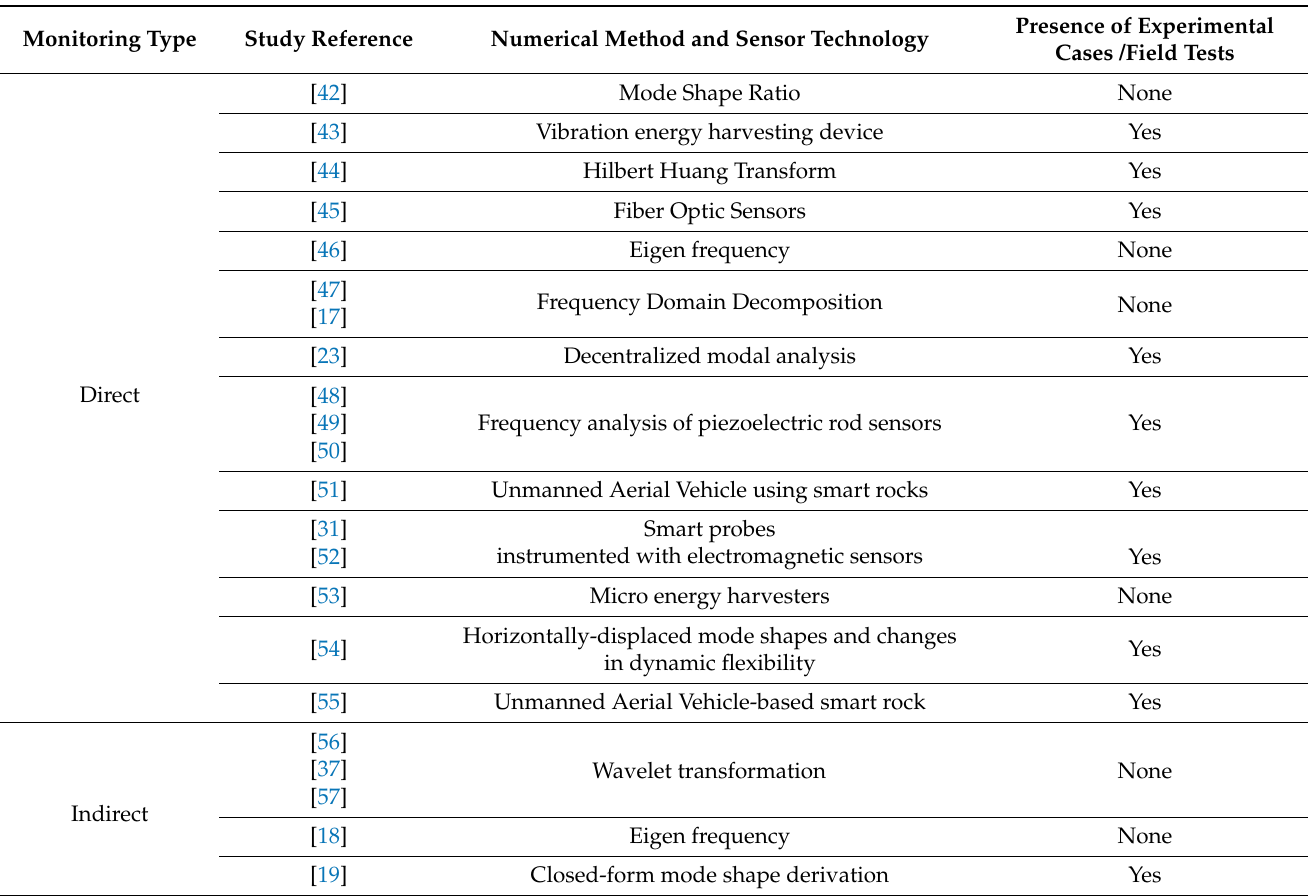
Table 1. List of monitoring-based scour detection